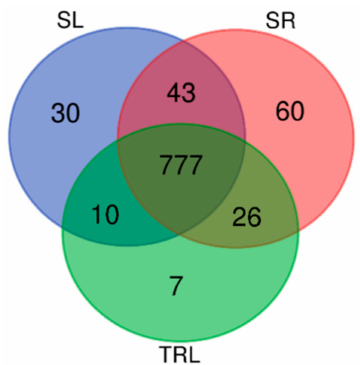
Figure 6. Three-way Venn diagram showing the numbers of shared and unique expressed transcription factors across the three tissues: SR (root), SL (sporophyll), and TRL (sporophyll with glandular trichomes removed).